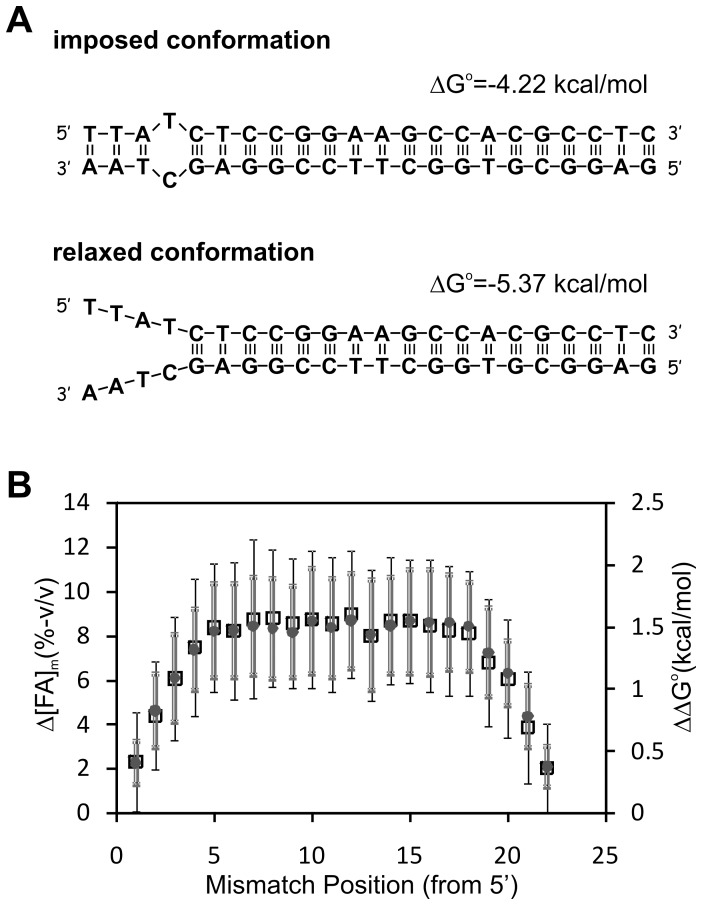
Effect of mismatch position on free energy and formamide denaturation.(A) Example probe (E844–865_4GT) with lower free energy at relaxed conformation as compared to imposed duplex with one mismatch. (B) Experimentally observed shift in the half-denaturation point (Δ[FA]1/2,exp – open squares and black error bars) and calculated minimum free energy change (ΔΔG° - grey circles and error bars) upon insertion of a single mismatch, as a function of mismatch position. Values, averages; error bars, standard deviations.